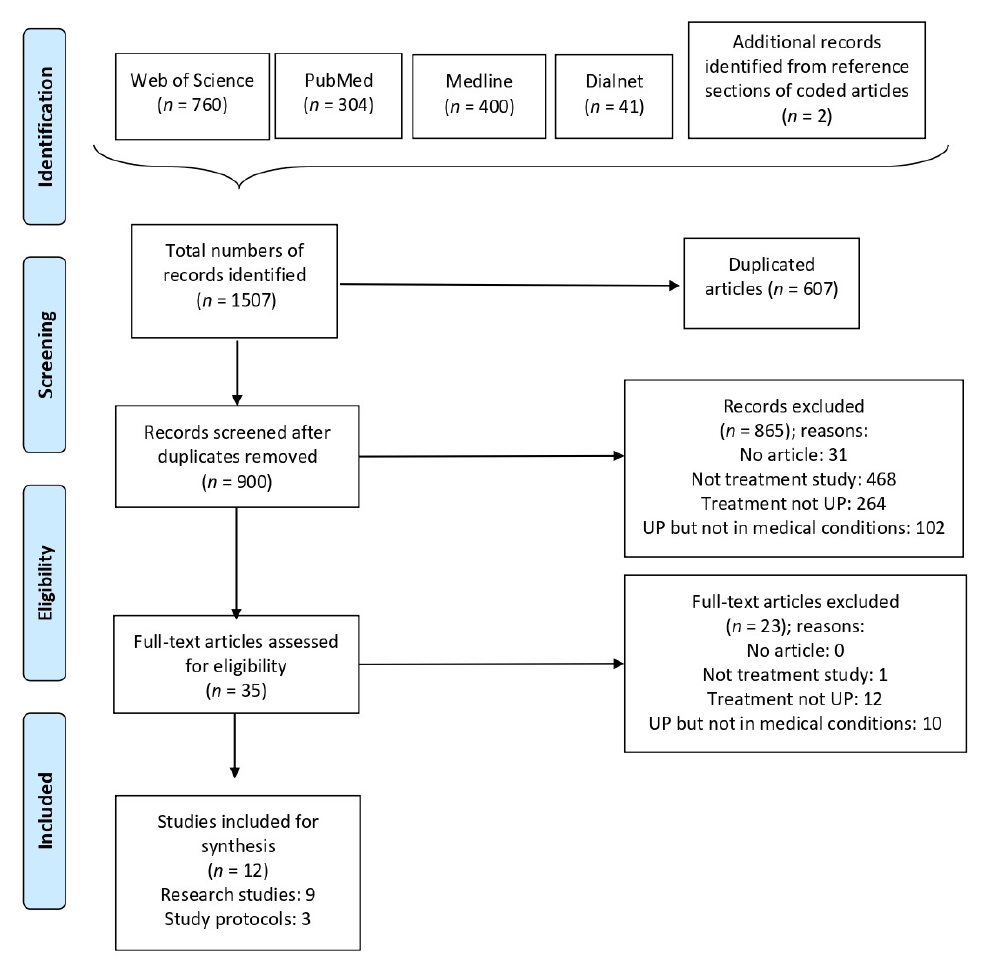
Figure 1. Flow diagram of the study selection following the PRISMA guidelines (Supplementary Table S1)